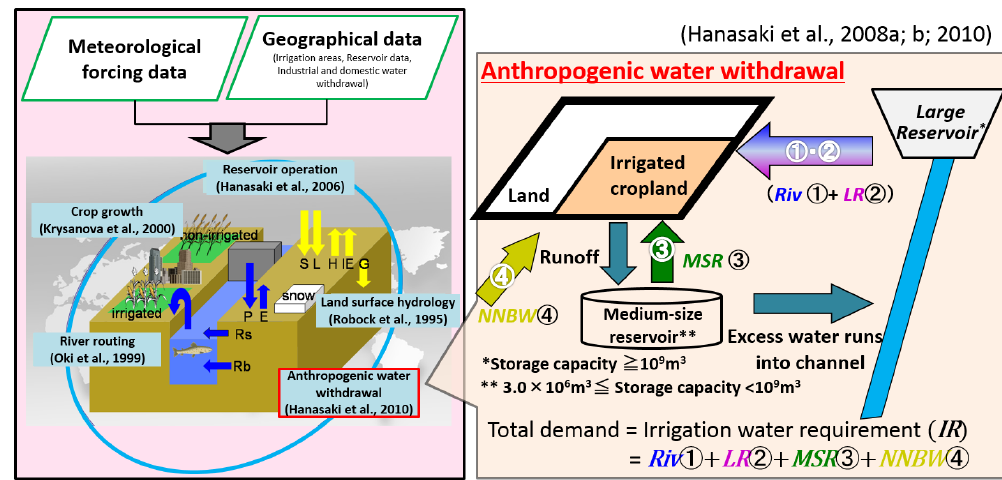
Figure 1. Schematic diagram of irrigation water requirements from various water supply sources in the H08